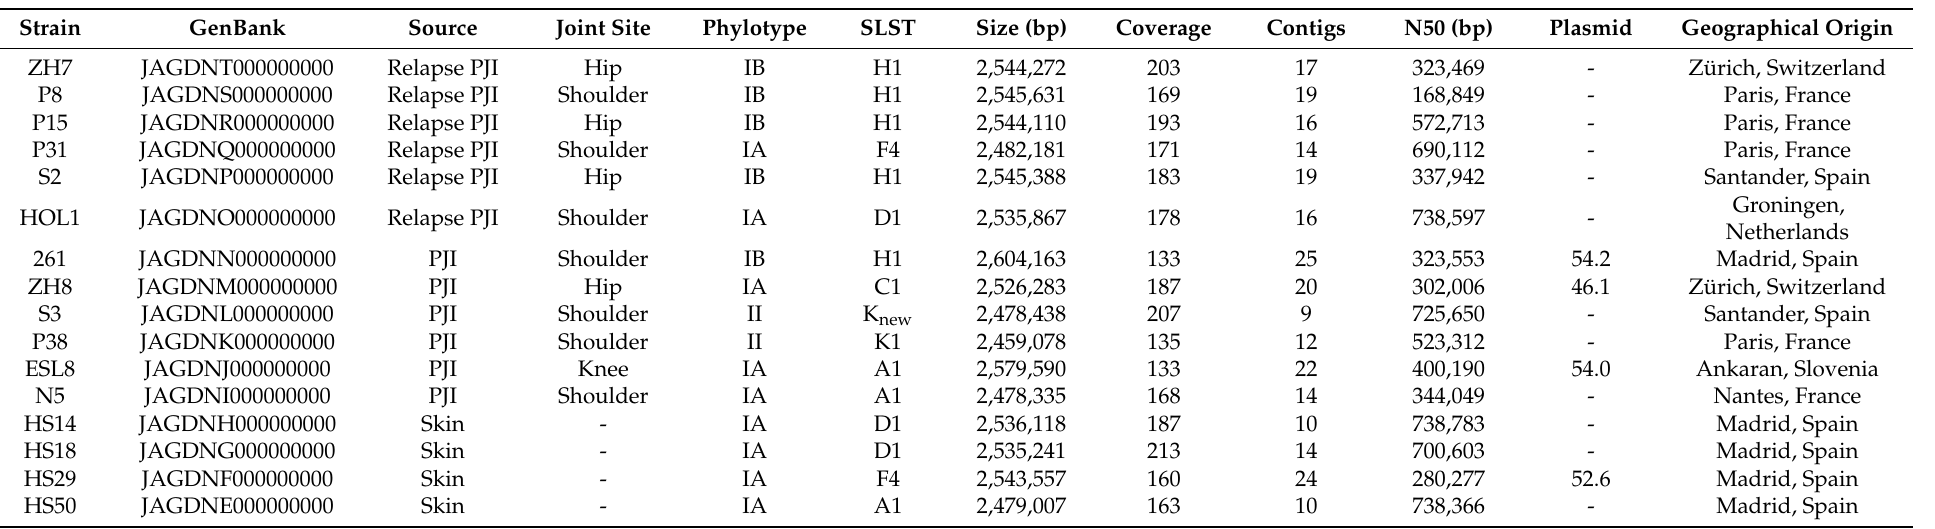
Table 1. Information regarding whole genome sequencing data of sixteen C. acnes